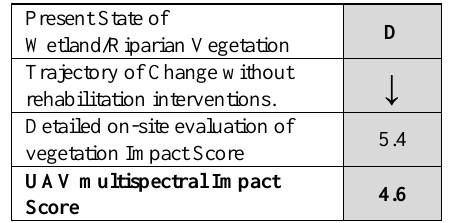
Table 7. Vegetative Health of the system and trajectory of